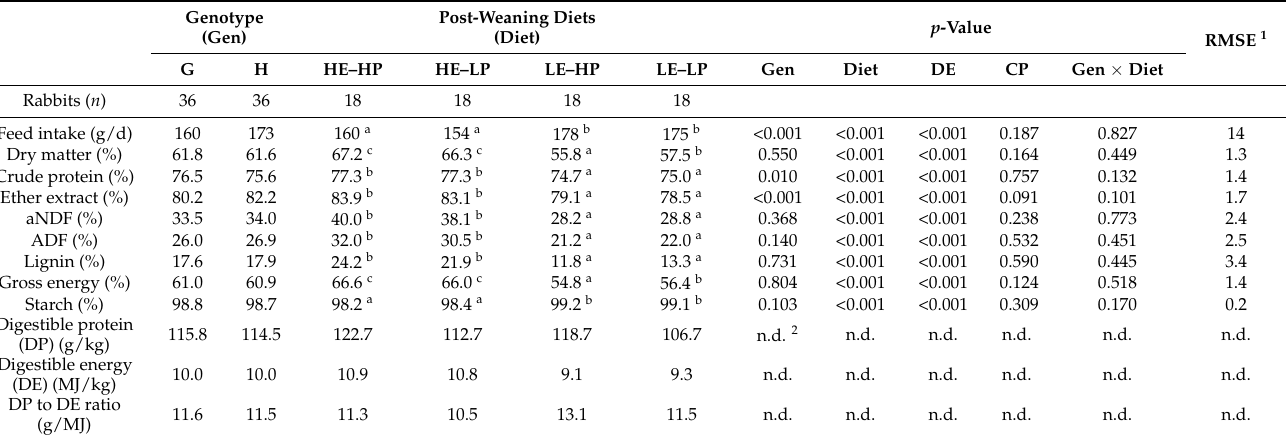
Table 3. Faecal apparent digestibility of nutrients and nutritive value (as-fed basis) of the post- weaning diets measured in a digestibility trial from 46 to 50 days of